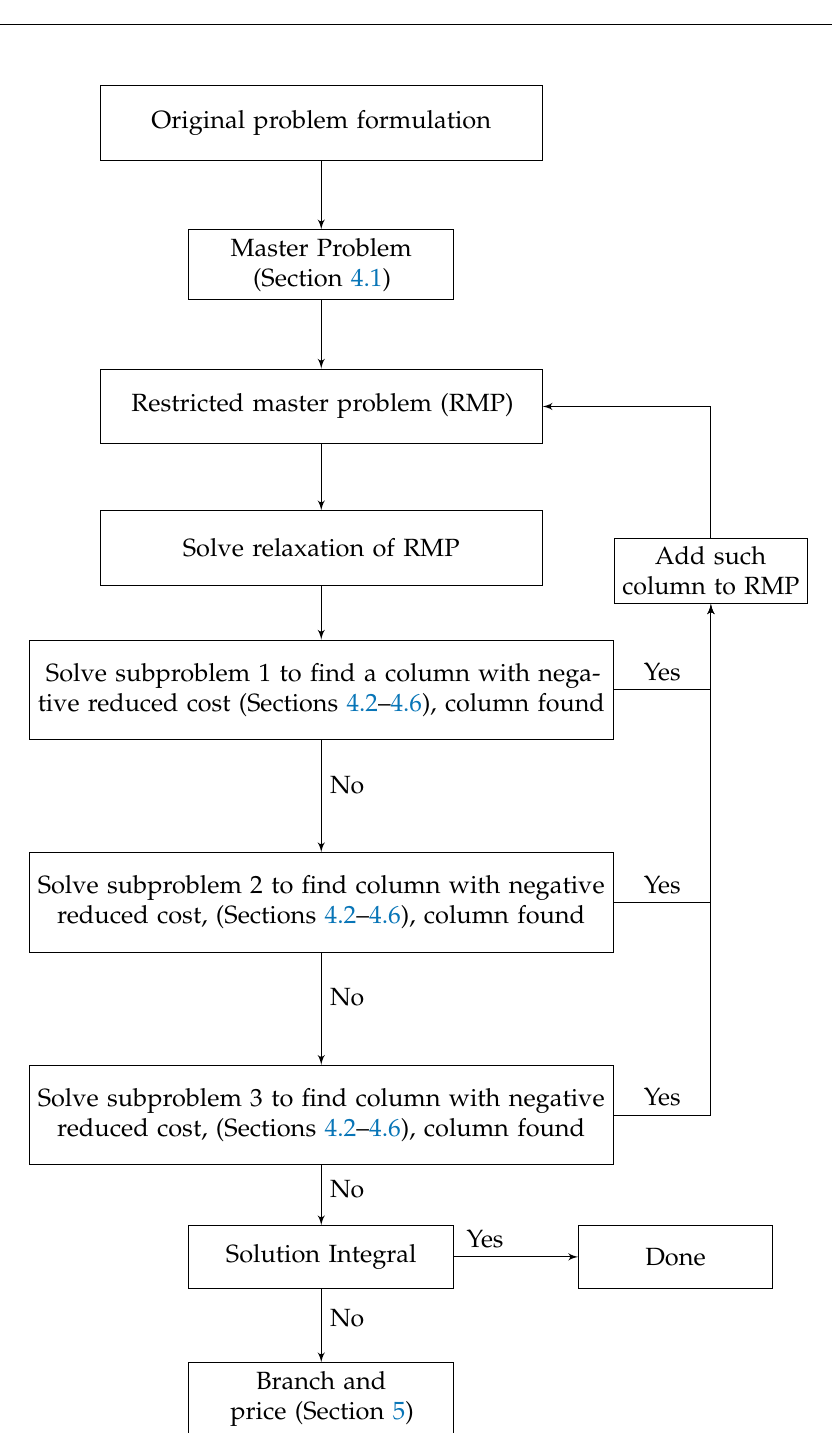
Figure 2. Column generation procedure for various